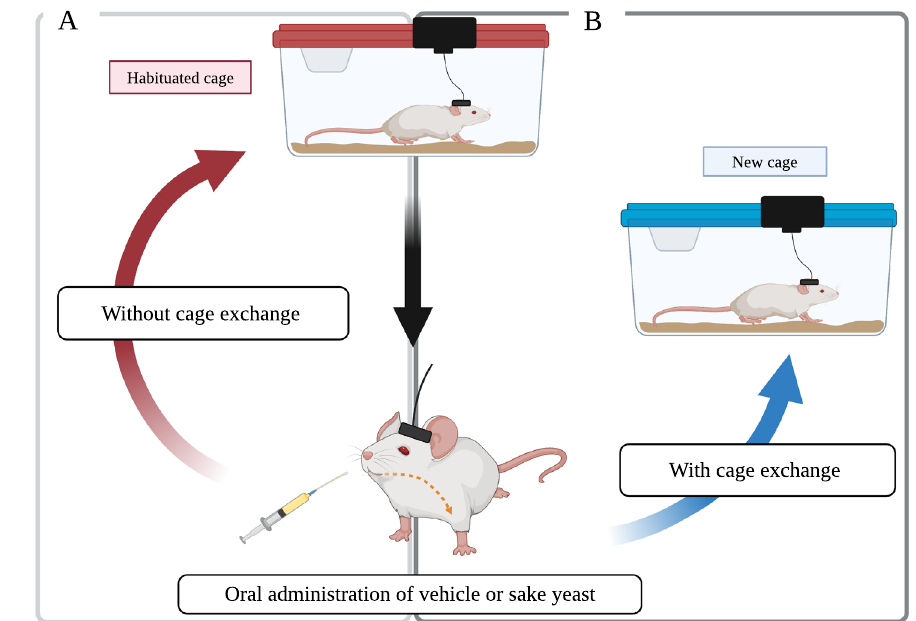
Figure 3. Procedure for the acute insomnia model. Each mouse was housed in its own individual habituated cage before oral administration. ( A ) In our preliminary experiment, each mouse was replaced in habituated cage (without cage exchange) immediately after oral administration of vehicle or sake yeast. ( B ) In the current study, each mouse was placed in a new, clean experimental cage supposing the condition of acute insomnia (with cage exchange) immediately after oral administration (Created with